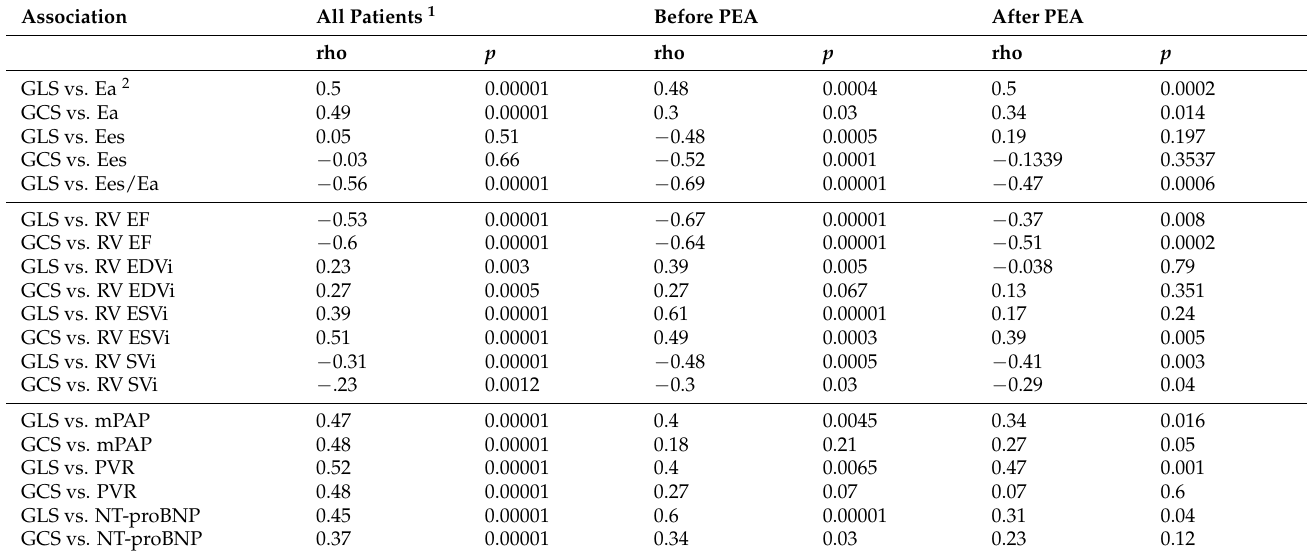
Table 3. Spearman correlation (rho) of strain and physiological parameters in the whole cohort and before/after PEA.